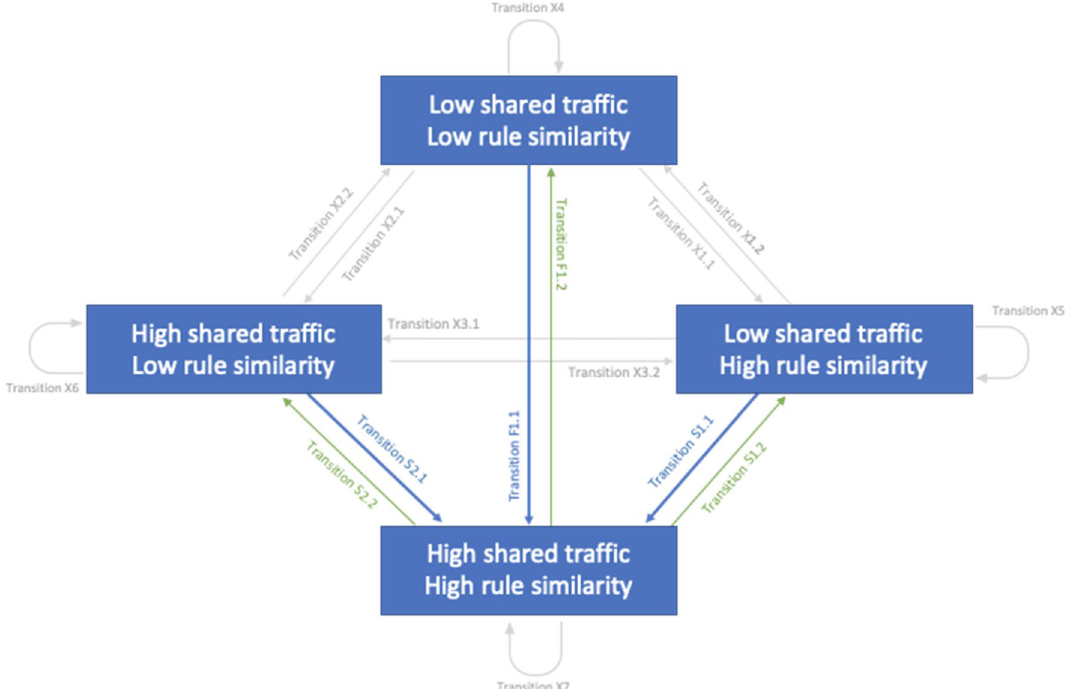
Figure 1. Dynamics of culture/institution interactions in terms of patterns of changes in the types of links that can connect two nodes We illustrate all possible transitions of interactions between shared traffic and rule similarities throughout the process of community development, which renders visible institutional processes over several timescales, and pits predictions of institutional effects on culture and cultural influence on institution. F represents fast-timescale transitions (in which the extent of shared governance and membership changed simultaneously in a month); S represents slow-timescale transitions (in which one changed before the other); X represents transitions that are irrelevant to the hypotheses.